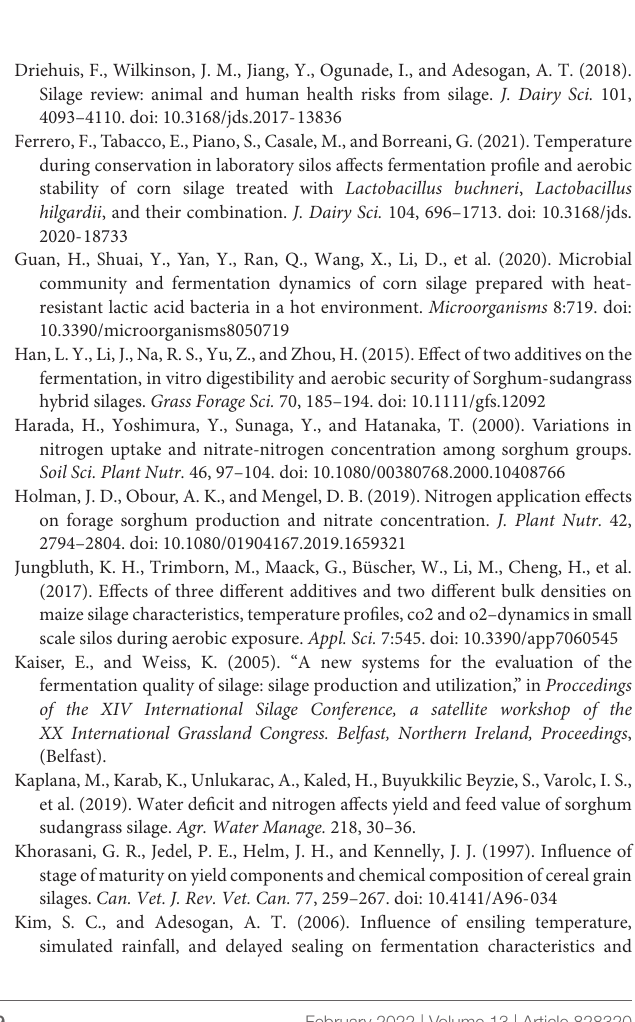
Supplementary Figure 1 | Bacteria community (species level) of sorghum-sudangrass silage ( n = 3). LT, storage temperature at 10 ◦ C; NT, storage temperature at 25 ◦ C; LD, ensiling density at 550 kg/m 3 ; HD, ensiling density at 650 kg/m 3 . Supplementary Figure 2 | Correlation networks among microbial counts and fermentation quality ( n = 12). p -Value <